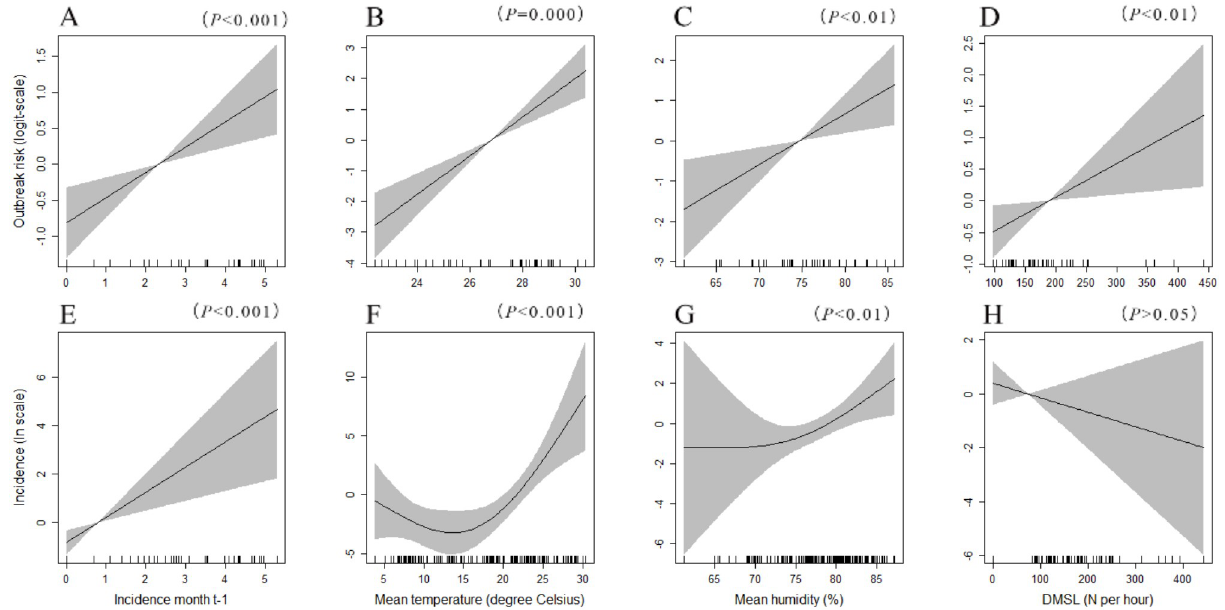
Fig 4. Analysis of potentially non-linear influences on the incidence of JE in Chongqing based on data from 2007–2019. In order to explain the zero inflation, (A) − (D) depict a separate binomial sub-model that quantifies predictor effects on the outbreak risk (logit-scale probability of incidence > 0) and (E) − (H) depict a lognormal sub-model that quantifies predictor effects on the outbreak intensity when an outbreak occurs [ln(incidence)].